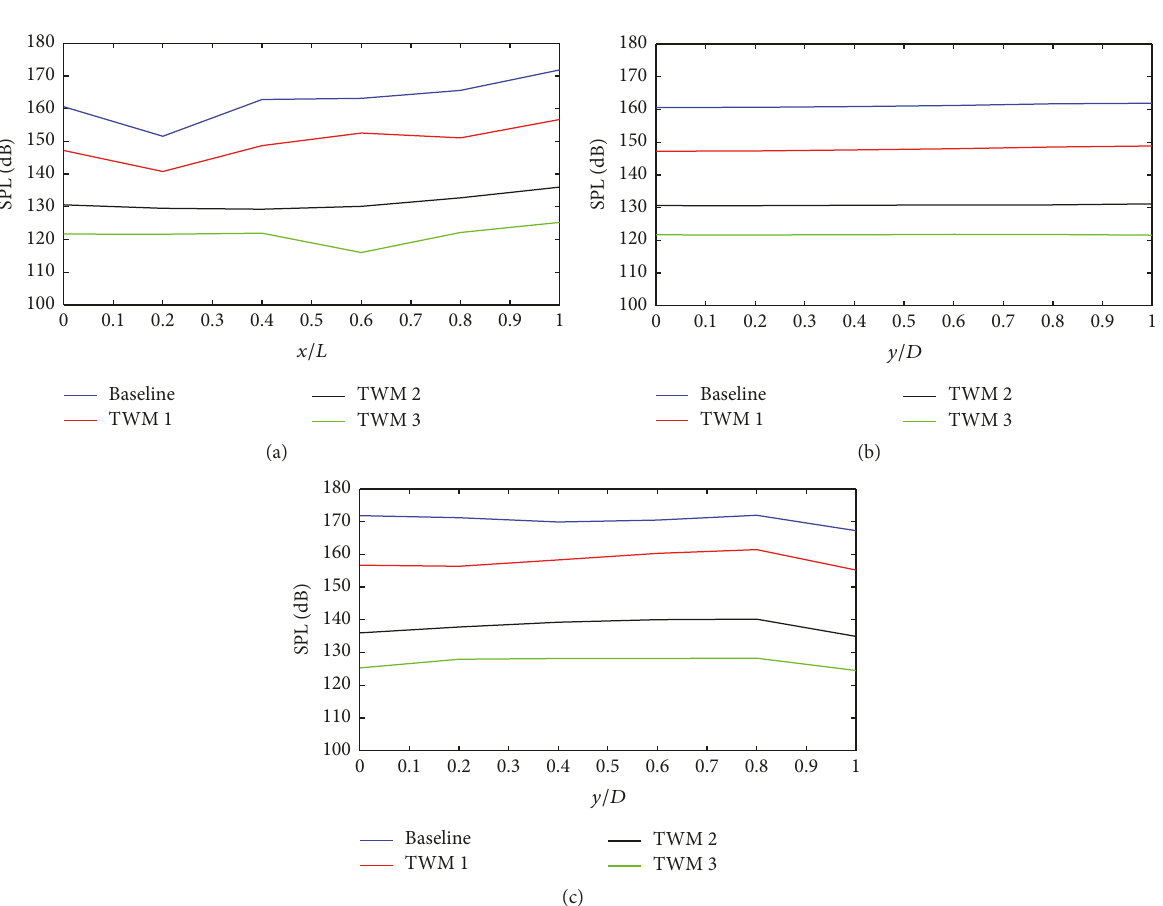
Figure 18: Sound pressure levels for cavity walls for TWM cases. (a) Bottom wall. (b) Leading edge wall. (c) Trailing edge wall.